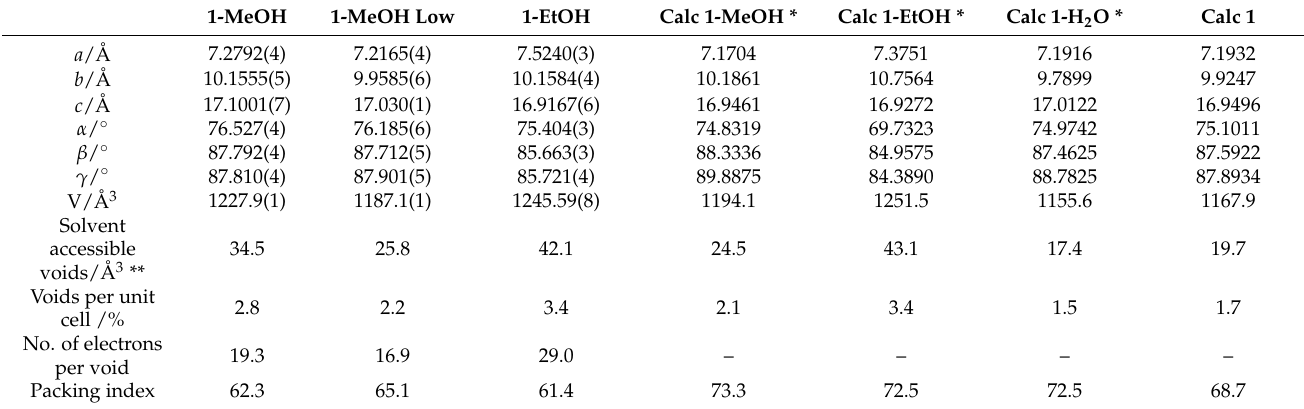
Figure 3. Thermogravimetric studies for 1-MeOH (TG and DTG in %). The mass loss of 3.55% corresponds to the weight of 0.5 methanol molecule. Green solid and dotted lines correspond to TG and DTG, respectively. The red dotted line shows temperature changes in time. Table 1. Unit cell and packing parameters for experimental and calculated structures.